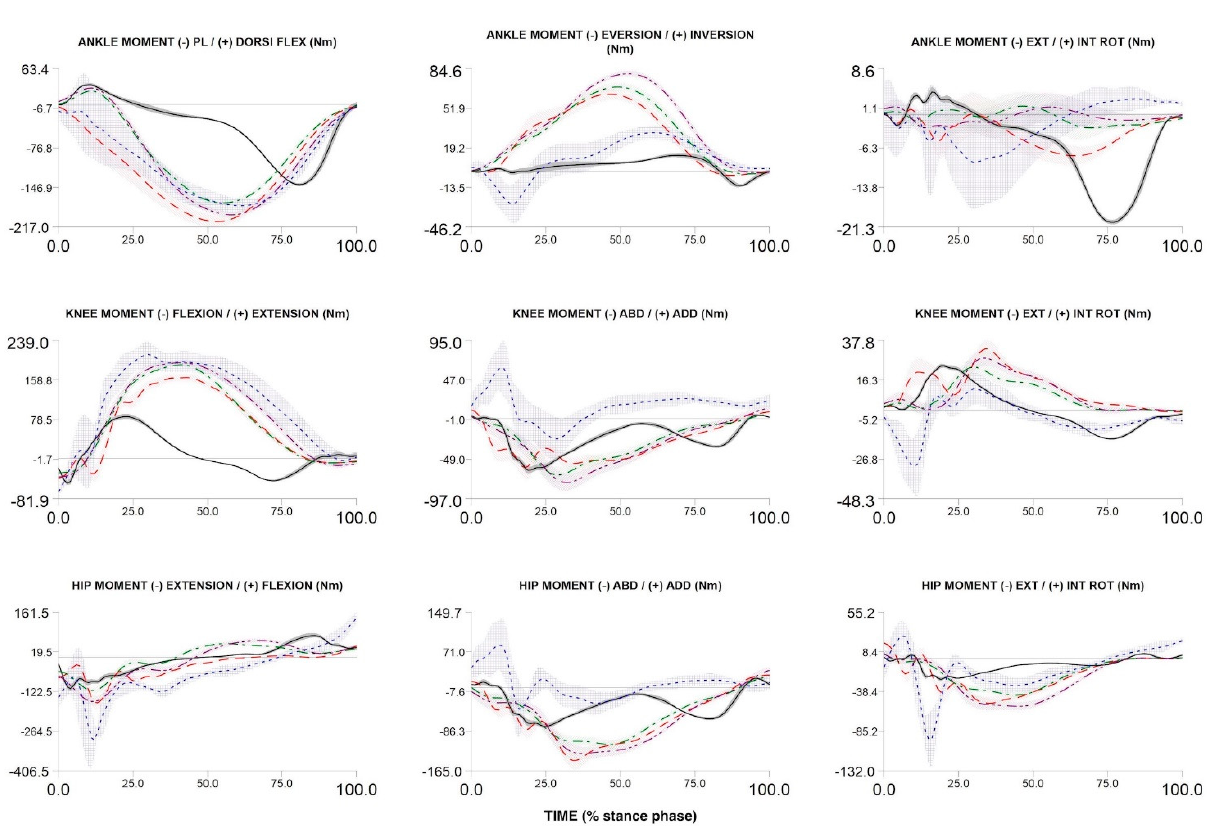
Figure 5. Three-dimensional ankle, knee and hip net moments during stance phase of walking, over-ground running, treadmill running (3.0 m / s and 75% of maximum VO 2 max test speed) and cutting maneuver in one participant. Over-ground running—red dash line; walking—black solid line; cutting maneuver—blue dot line; TR3—green dash dot line; TRA—purple dash dot dot line.